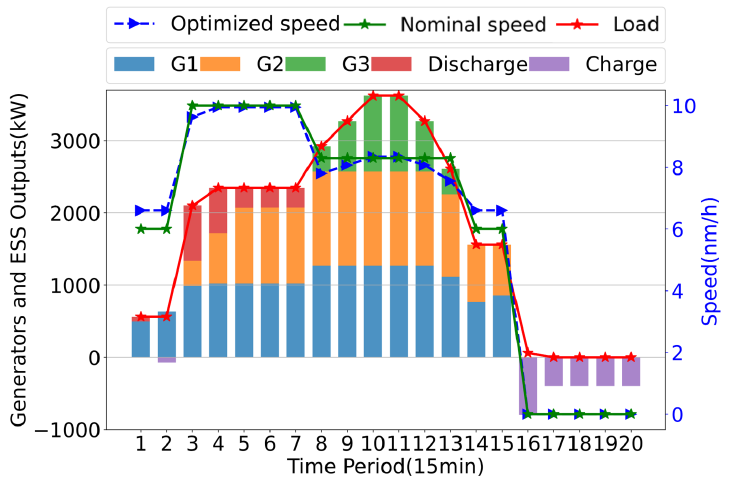
Figure 5. Optimization of power generation and navigation speed